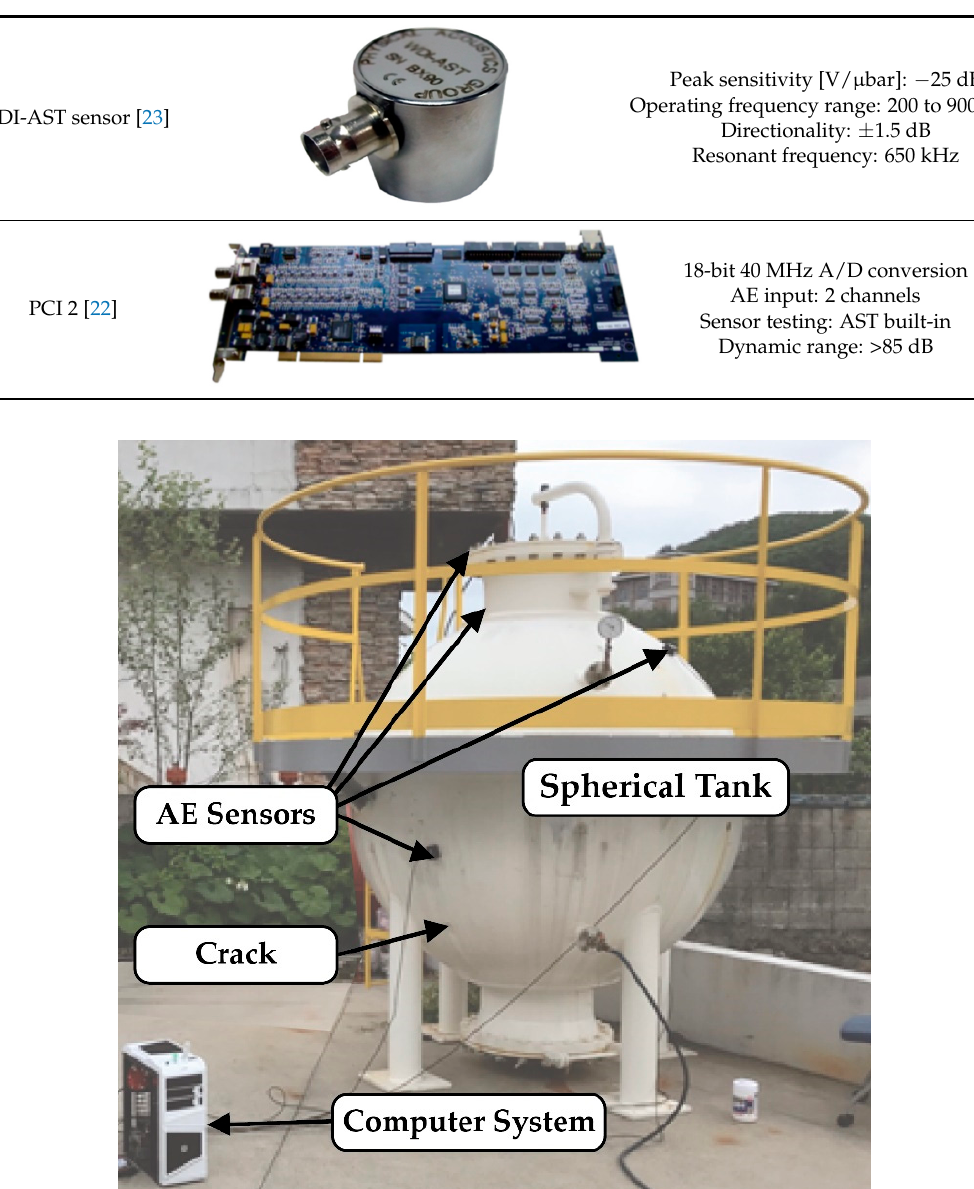
Table 1. Specifications of the proposed data acquisition system.